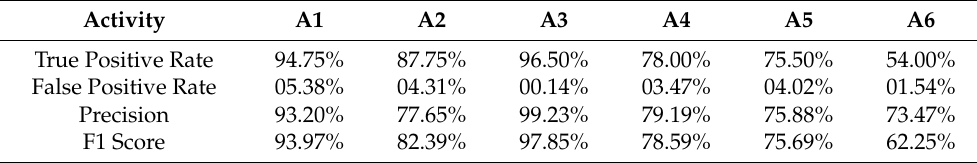
Table 9. The results of our proposed approach obtained for the second evaluation scenario.